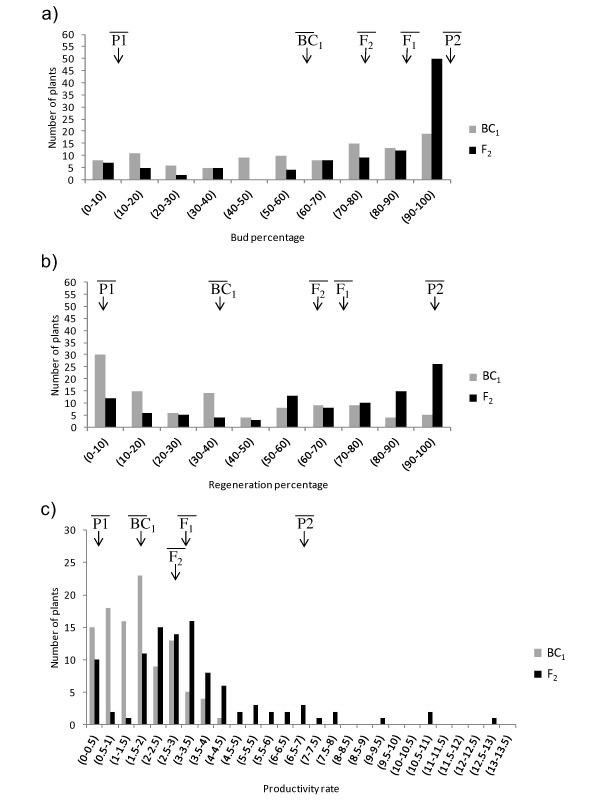
Population distributions for regeneration traits. a) The percentage of explants with buds (B), b) The percentage of explants with plants (R) and c) The percentage of plants per explant with shoots (PR). The F2 population (dark) is derived from selfing an F1, the result of a cross between the tomato cv. Anl27 (P1) and S. pennellii PE-47 (P2). The BC1 population (grey) is the result of crossing the tomato cv. Anl27 and the F1 plants. Maternal (P1), Paternal (P2), F1, F2 and BC1 mean values are indicated by arrows.